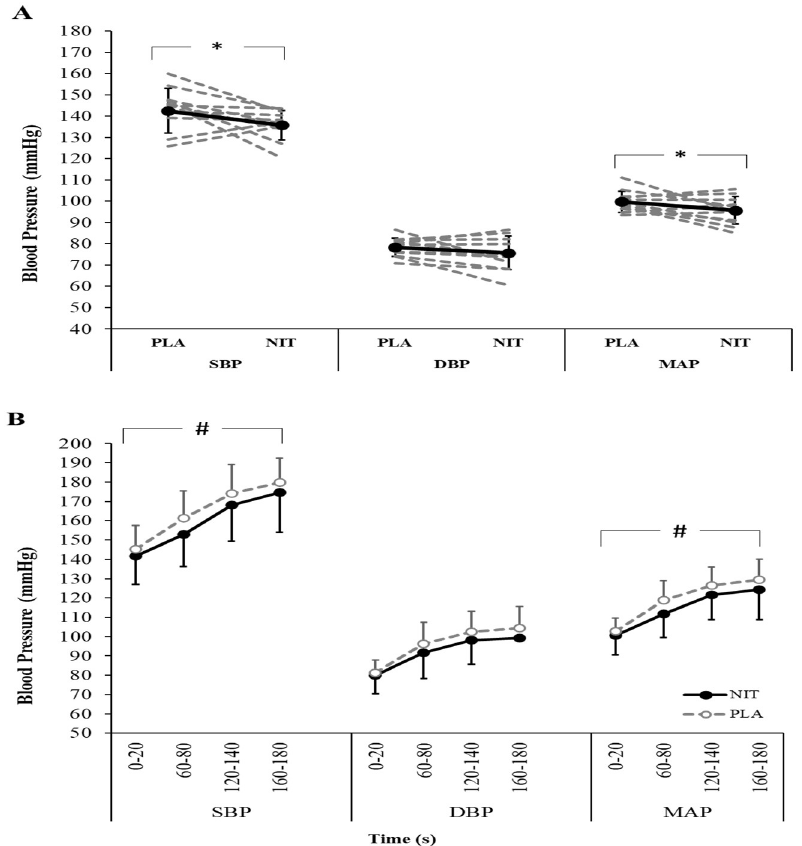
Figure 3. Systolic blood pressure (SBP), diastolic blood pressure (DBS), mean arterial pressure (MAP) during short isometric contraction ( A ) and a sustained ischaemic contraction ( B ) following nitrate (NIT) and placebo (PLA) supplementation. Data are mean ± SD. * P = 0.030 for SBP and P = 0.041 for MAP. # Main effect of supplementation, P = 0.040 for SBP and P = 0.021 for MAP.